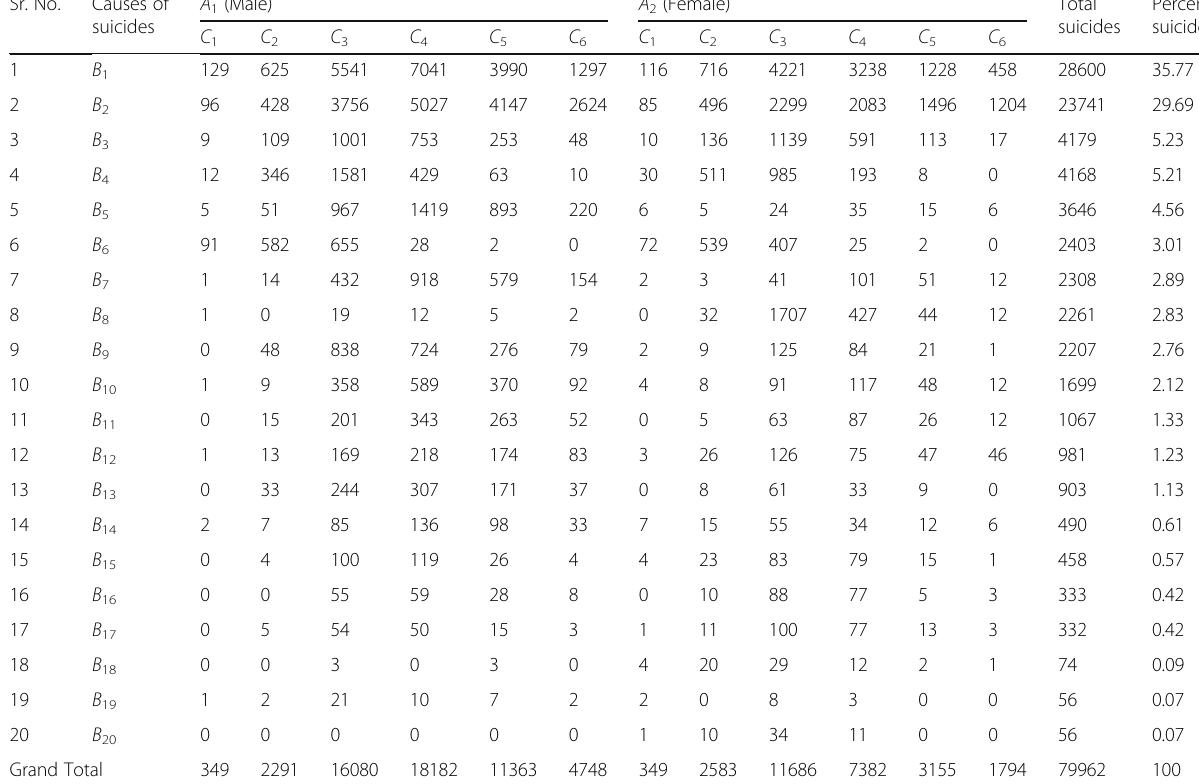
Table 2 Distribution of suicides in 2014 by causes of suicides and gender across age group Sr. No. Causes of suicides